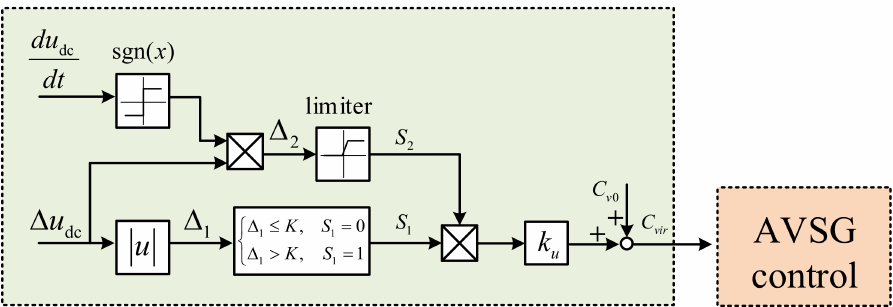
Figure 13. Control architecture for improved AVSG proposed in Reference